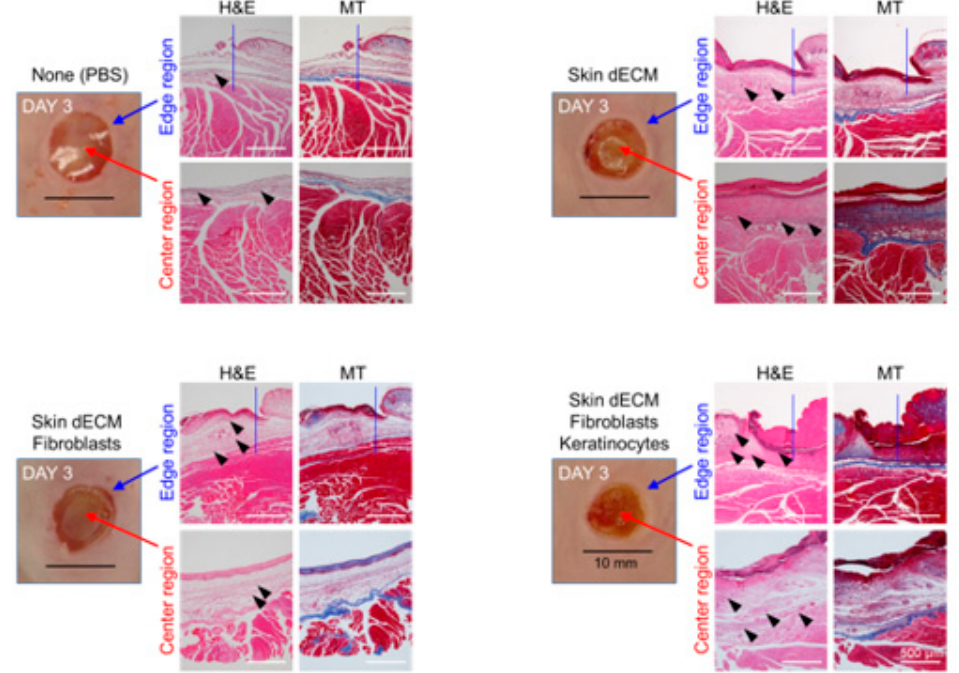
Figure 4. Histological analysis of cell infiltration and collagen deposition. Tissues stained with hematoxylin and eosin, and Masson’s trichrome stain, were analyzed at various stages on day 3. The images show stained tissue samples depicting the infiltration of cells into the dermal layer (black arrow heads) and fibrosis and collagen deposition at the site of damage (yellow line).